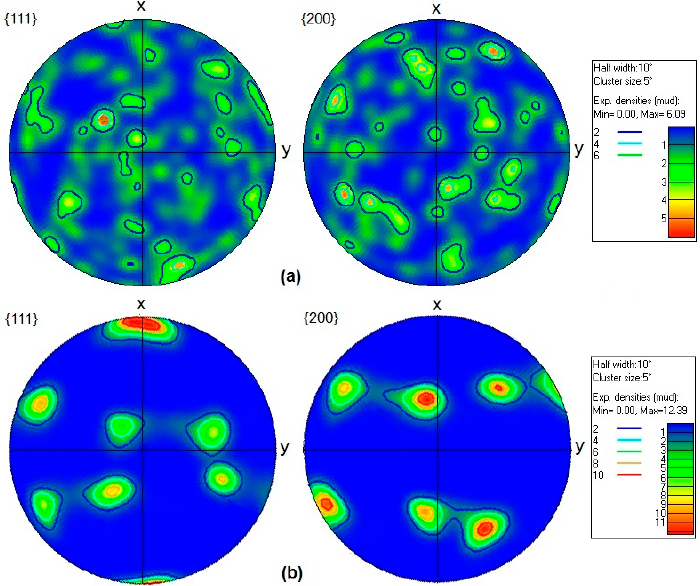
Figure 12. {111} and {200} pole figures of the annealed AA ‐ 6063 alloy: ( a ) before and ( b ) after